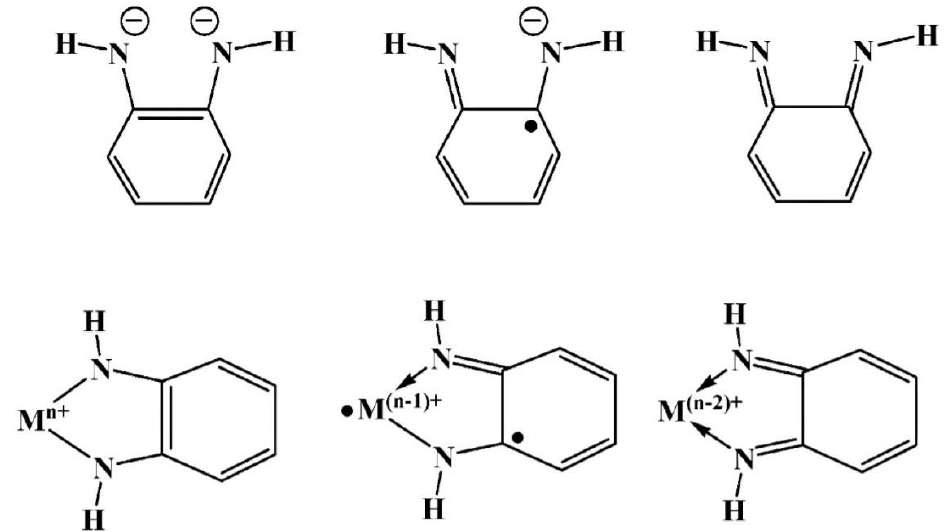
Figure 4. The behavior of non-innocent ligand upon complexation [122]. Reprinted with permission from Anillo, A.; Díaz, M. R.; García-Granda, S.; Obeso-Rosete, R.; Galindo, A.; Ienco, A.; Mealli, C. Structural and electronic rearrangements upon the oxidation of binuclear (Ru 2 ) and trinuclear (MoRu 2 ) complexes with bridging o -phenylenediamido ligands. Organometallics 2004, 23 (3), 471–481. Copyright (2004) American Chemical Society.